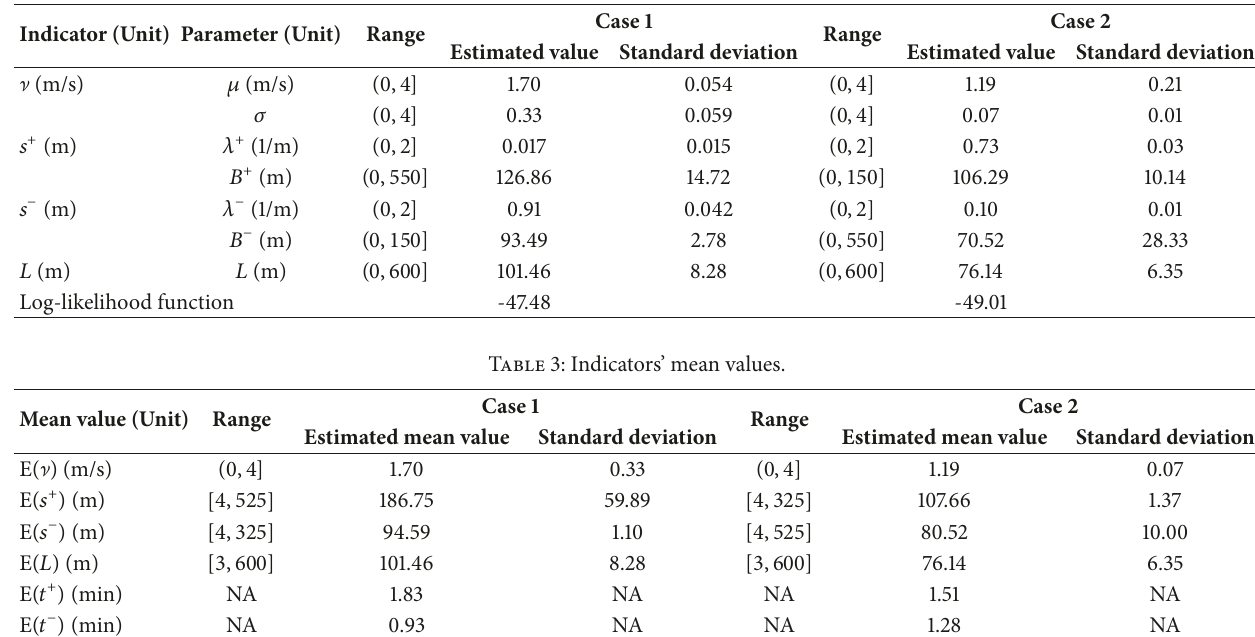
Table 2: Parameter estimation for a single passenger by MLE.